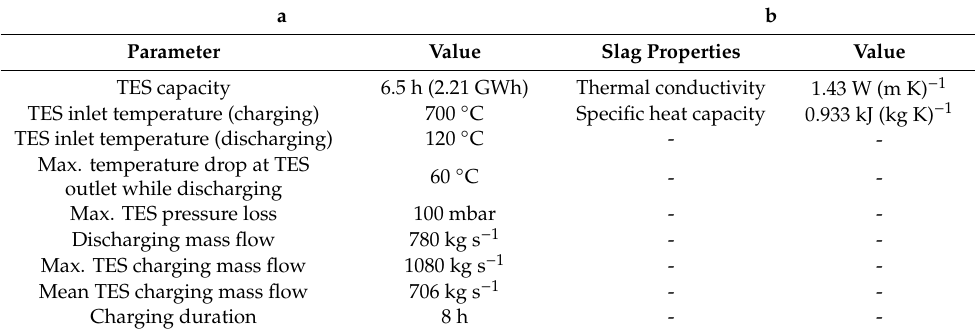
Table 1. Operation specifications for a 150 MW el CSP plant (a) and used slag parameter (b) [27].